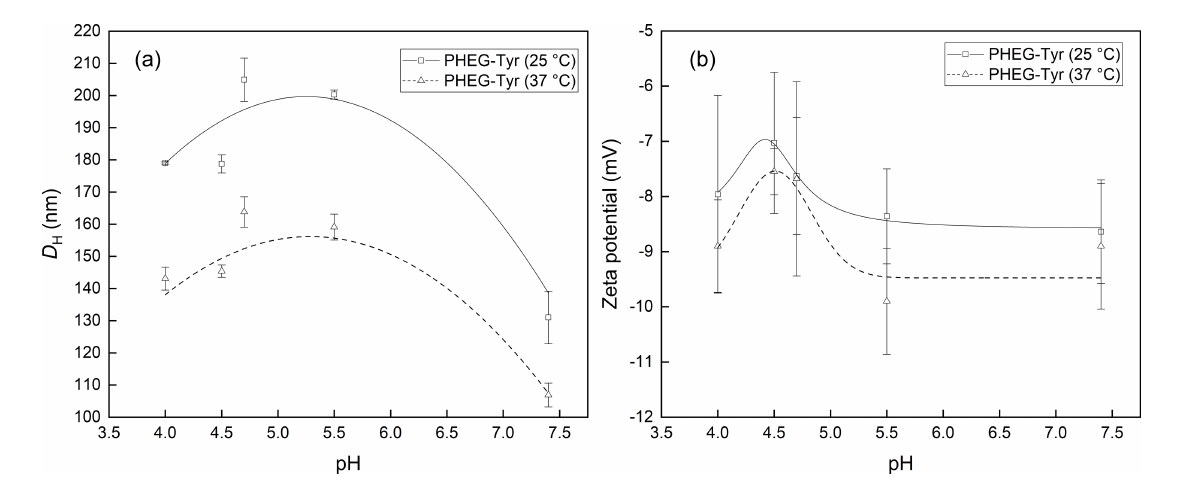
Figure 2: Dependence on the pH value of D H (a) and zeta potential (b) of PHEG-Tyr nanogel at 25 (squares) and 37 °C (triangles). The lines are to guide the eye.